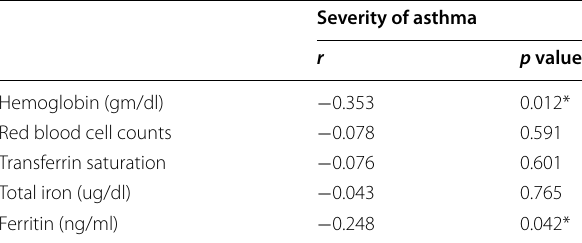
Table 5 Correlations between severity of asthma with haemoglobin level, iron profile, using Pearson correlation coefficient in asthmatic patients (with and without IDA)